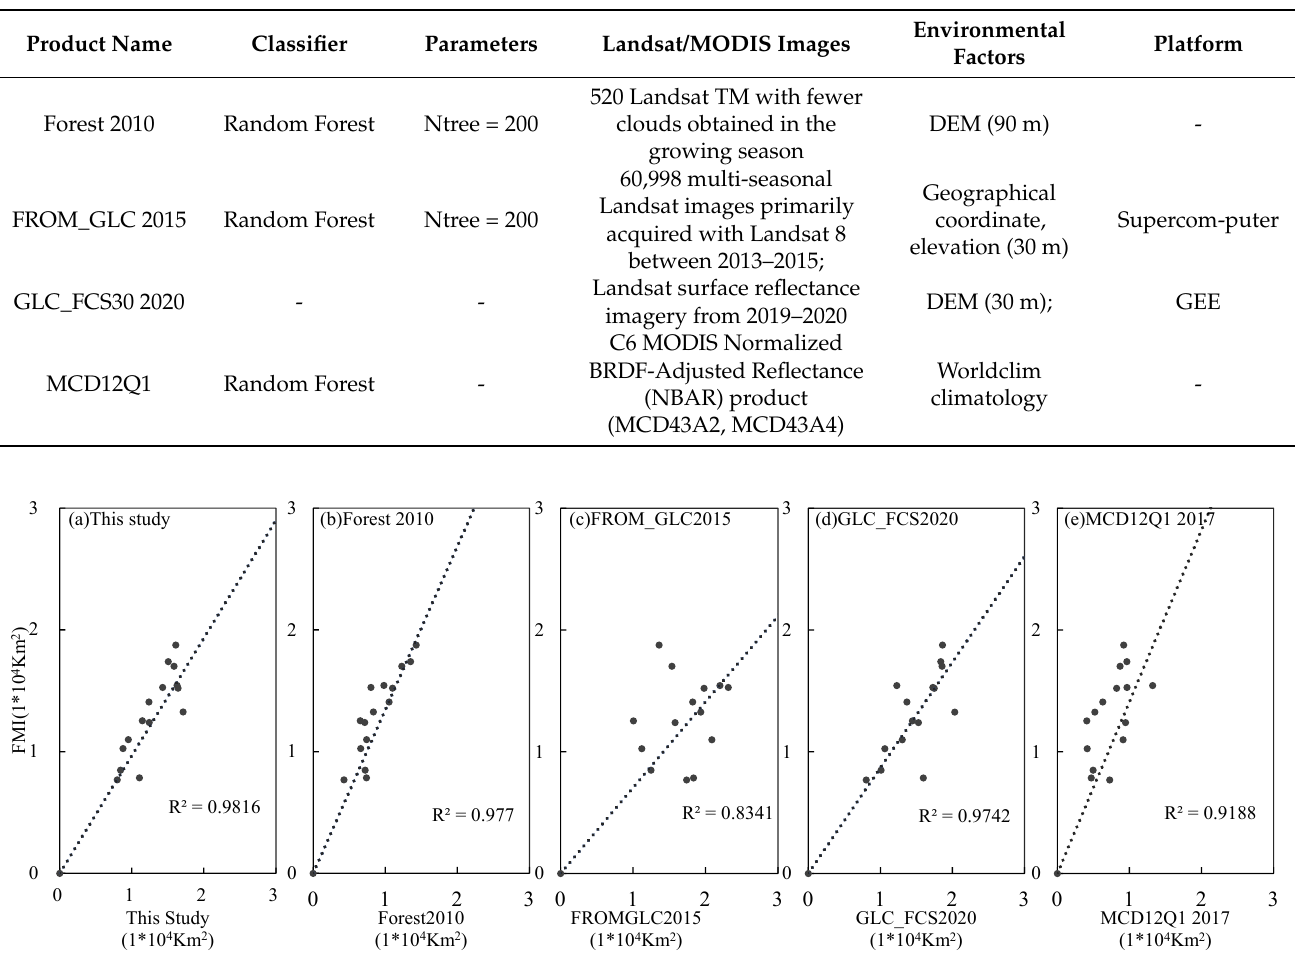
Figure 13. Comparison of forest coverage area between FMI and the products of this study and four references. ( a ) This study; ( b ) Forest 2010; ( c ) FROM_GLC2015; ( d ) GLC_FCS2020; and ( e ) MCD12Q1 2017. FMI: Forest Management Inventory statistics.